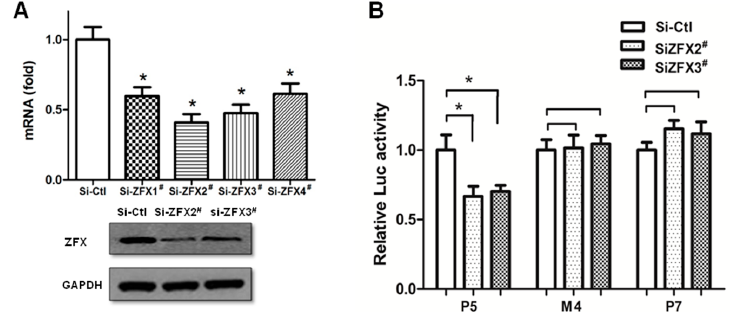
Figure 5. Removal of ZFX-binding site led to a loss of response to ZFX knockdown. ( A ) HeLa cells were transfected with either the non-specific siRNA (Si-Ctl) or one of four ZFX-targeting siRNAs (Si-ZFX1 # , Si-ZFX2 # , Si-ZFX3 # and Si-ZFX4 # ). Si-ZFX2 # and Si-ZFX3 # were found to be the most effective for ZFX knockdown. Top panel: Measurement of ZFX mRNA levels. Bottom panel: Western blotting detection of ZFX protein, with GAPDH detected as a control for protein loading; ( B ) When ZFX expression was knocked down, a decreased reporter activity was observed in the P5 construct containing the Site4 ZFX-binding sequences. No change of reporter activity was observed in P7 in which Site4 was deleted. Similarly, no change in reporter activity was observed in M4 in which Site4 sequences were mutated. Results are presented as means ± SD from three independent experiments. (*, p < 0.01).